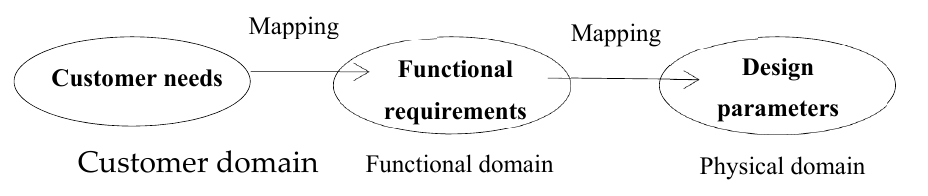
Figure 2. Mapping between the domains.